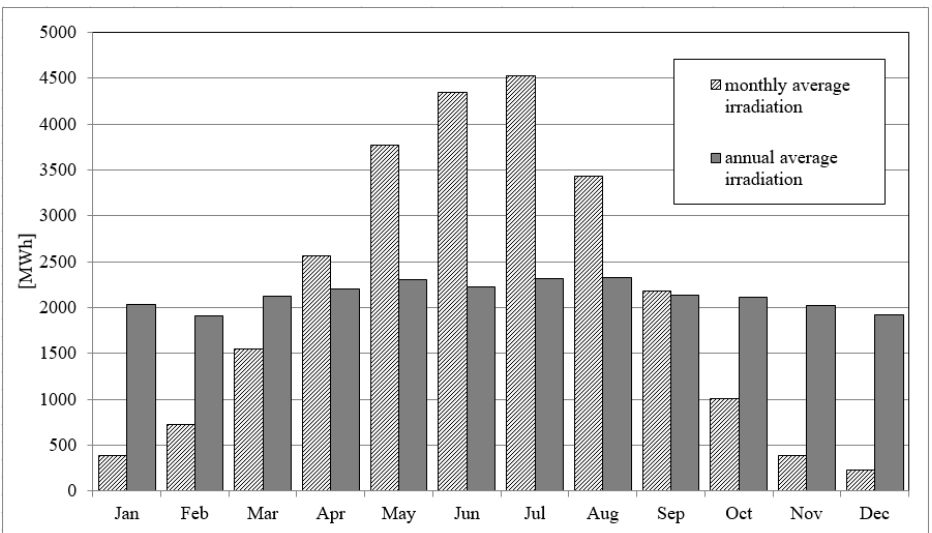
Figure 5. Annual cycle of solar radiation on vertical walls of 130 buildings in the research area. Greyish bars result from annual averaged radiation input values, dashed bars from monthly averaged input values (from German Weather Service, 2016). Values accumulate from all wall surfaces without a distinction of